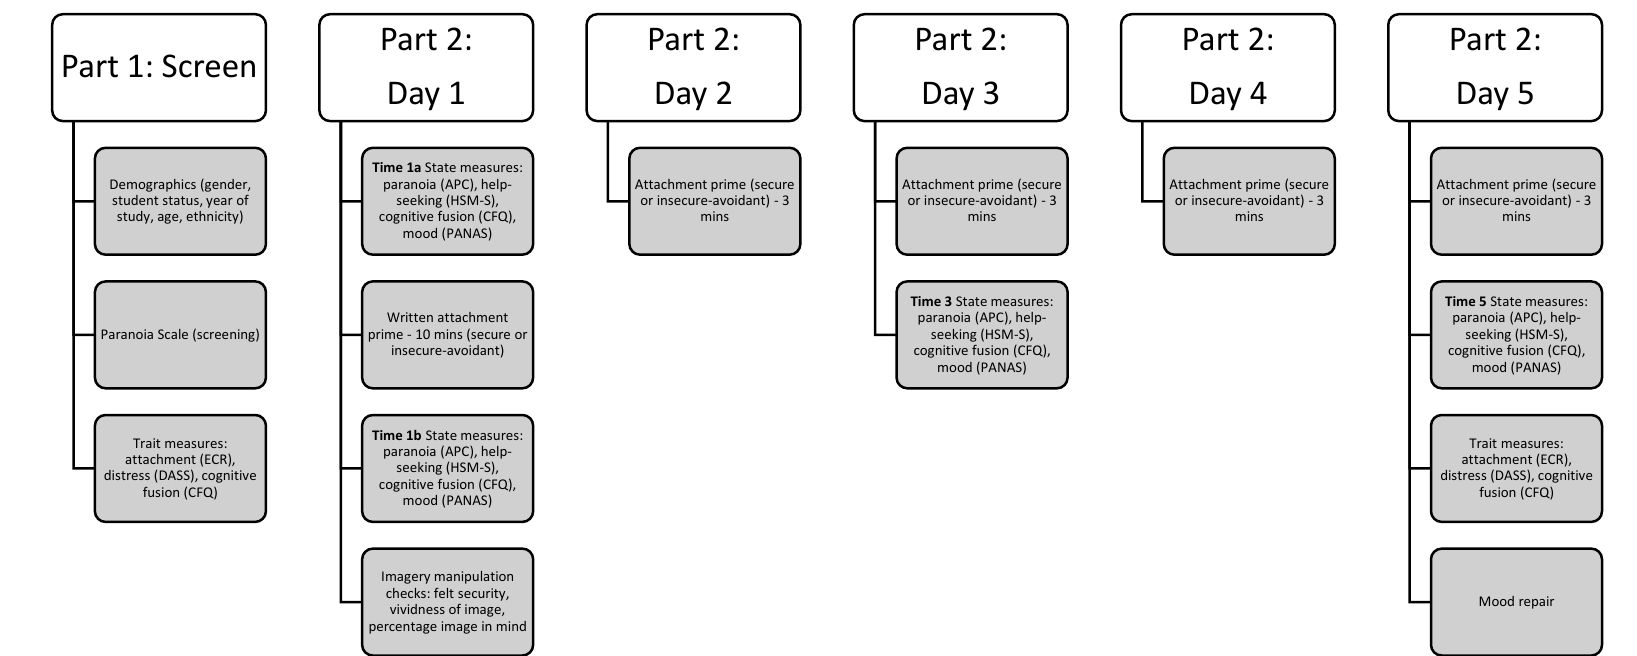
Figure 1. Study Procedure. Note: ECR = Experiences in Close Relationships Inventory; DASS = Depression Anxiety Stress Scale; CFQ = Cognitive Fusion Questionnaire; APC = Adapted Paranoia Checklist; HSM-S = State Help-Seeking Measure; PANAS = Positive and Negative Affect Schedule.